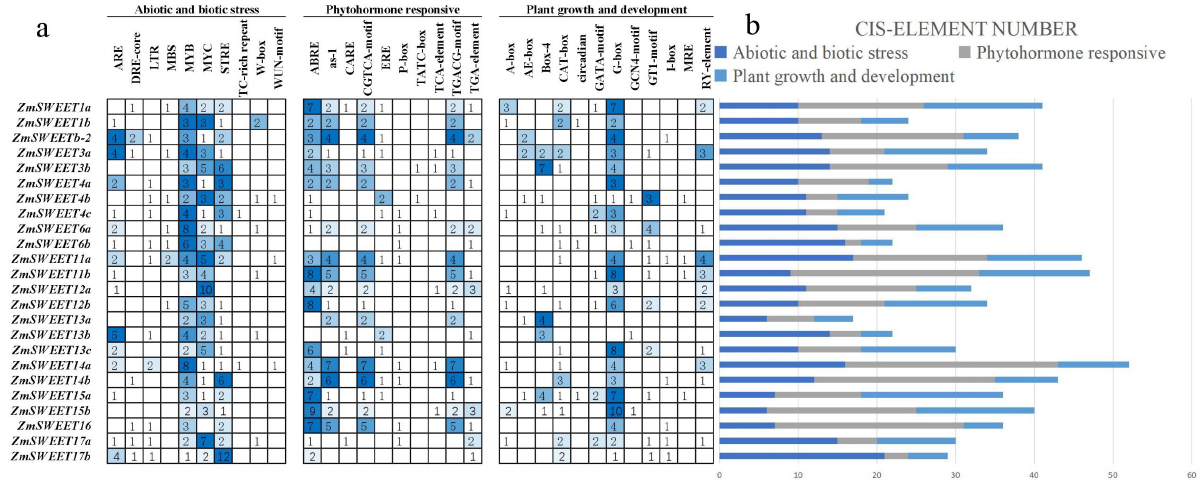
Figure 5. Cis -acting elements in the ZmSWEET gene family. ( a ) Numbers of different elements in the promoter region of the ZmSWEET genes, as indicated by different color intensities and numbers in the grid. ( b ) Total number of cis -acting elements in each response category. Dark blue indicates abiotic and biotic stresses, gray indicates phytohormones, and light blue represents plant growth and development.